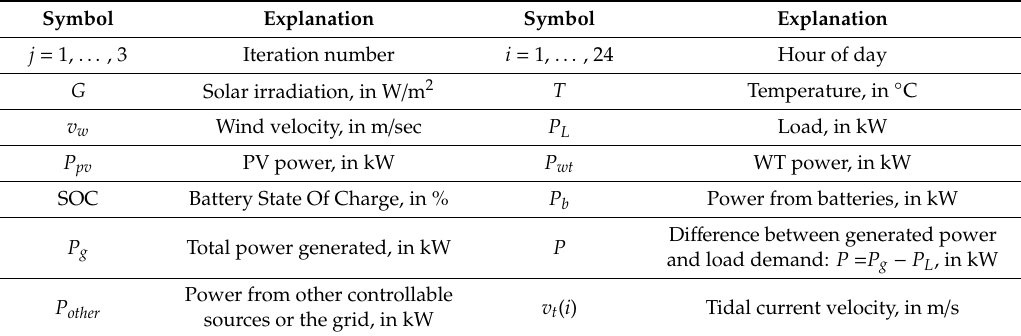
Table 1. Explanation of symbols used in the flow chart of Figure